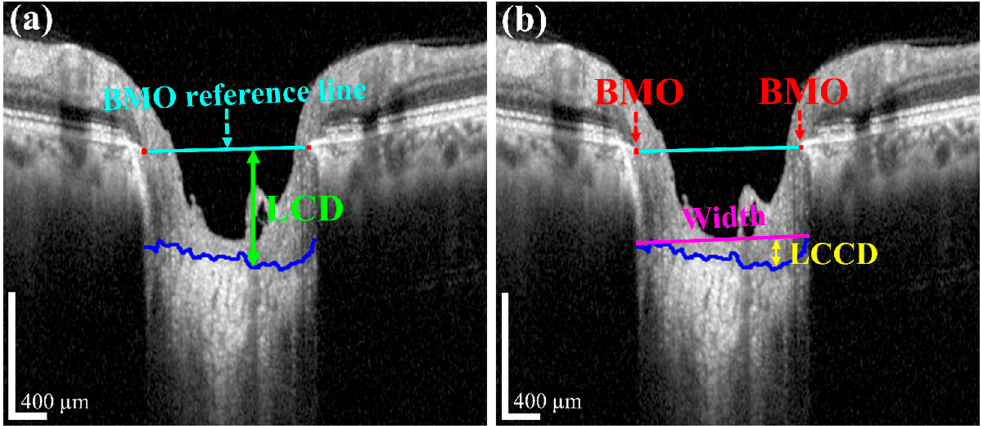
Figure 3. Measurement of LCD and LCCD : ( a ) LCD (lime green line) is the maximum distance from the BMO reference line (cyan line) to the anterior LC surface (blue curve); ( b ) LCCD (yellow line) is the maximum depth of the LC surface width (magenta line) to the anterior LC surface. Scale bar: 400 µm.